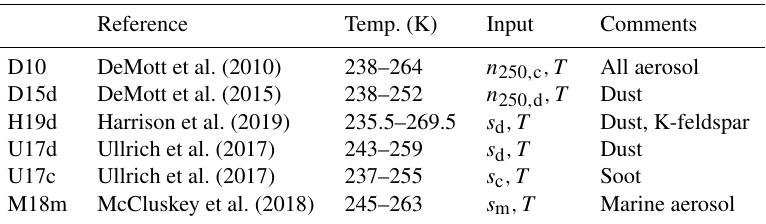
Table 2. The INP parameterizations for immersion freezing, with their references and valid temperature intervals. In the case of immersion freezing, ice nucleation starts via an INP immersed into a liquid